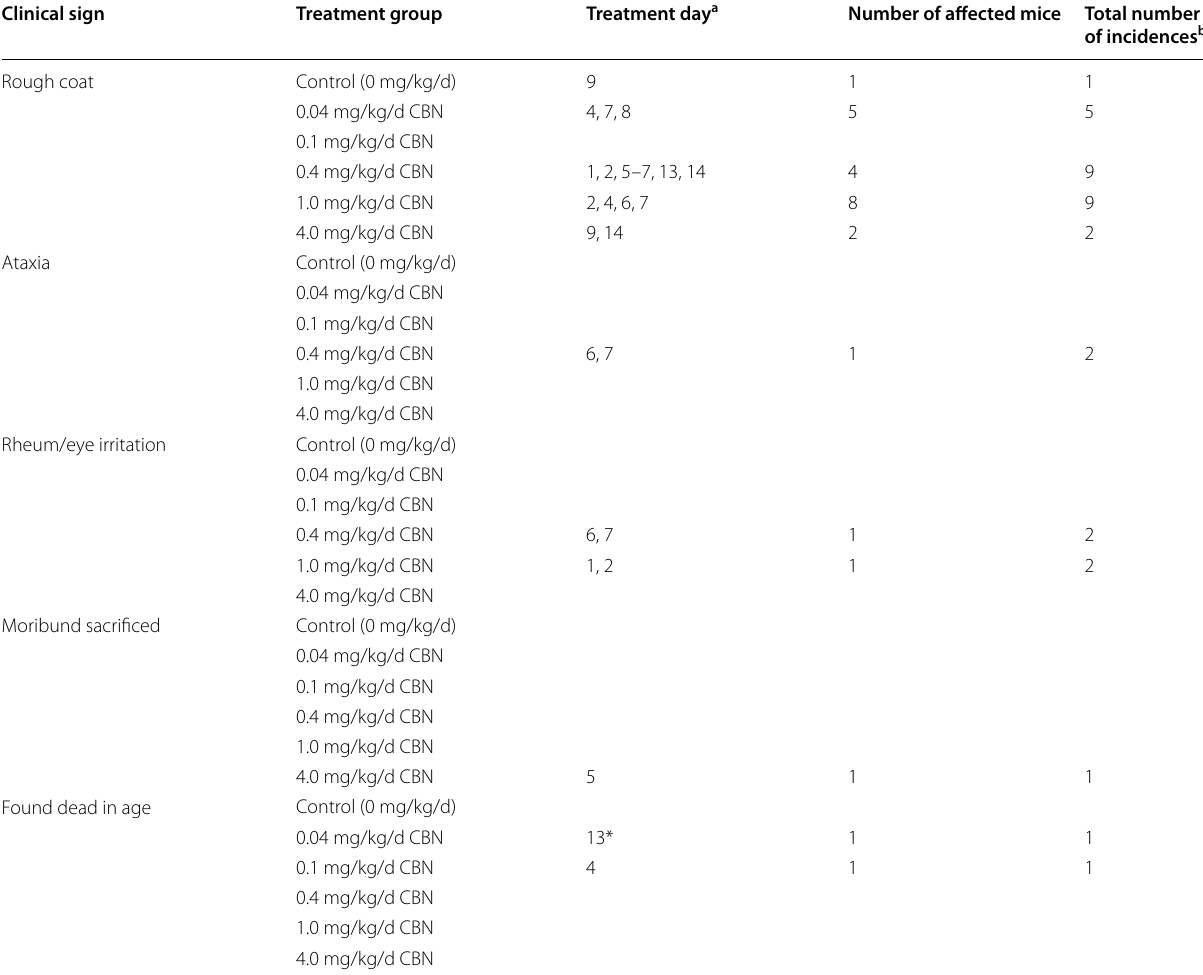
Table 1 Incidence of adverse clinical signs in mice dosed with